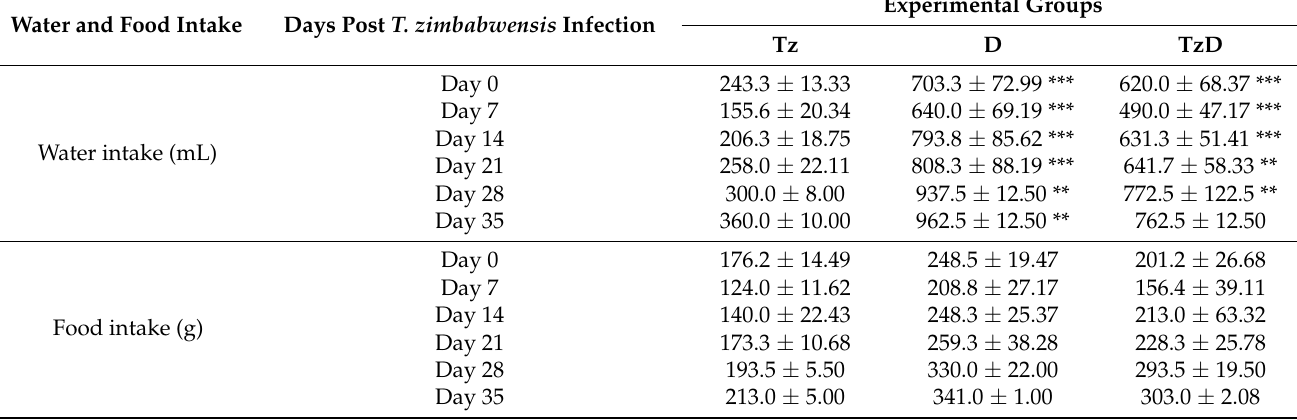
Table 2. Mean water and food intake in male Sprague Dawley rats comorbid with type 2 diabetes mellitus and Trichinella zimbabwensis . Sprague Dawley rats were infected with T. zimbabwensis (Tz); with induced type 2 diabetes (D) and co-morbid with T. zimbabwensis and type 2 diabetes (TzD). Day 0 represents the day of Tz infection to diabetic rats with L3 from muscles. n = 6 for each group. Values with asterisks represent significant differences between the experimental groups, (** p < 0.01, *** p < 0.001)